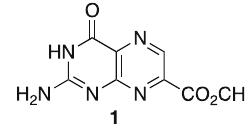
Figure 1: 7 - carboxymethyl - pterin ( 1 )